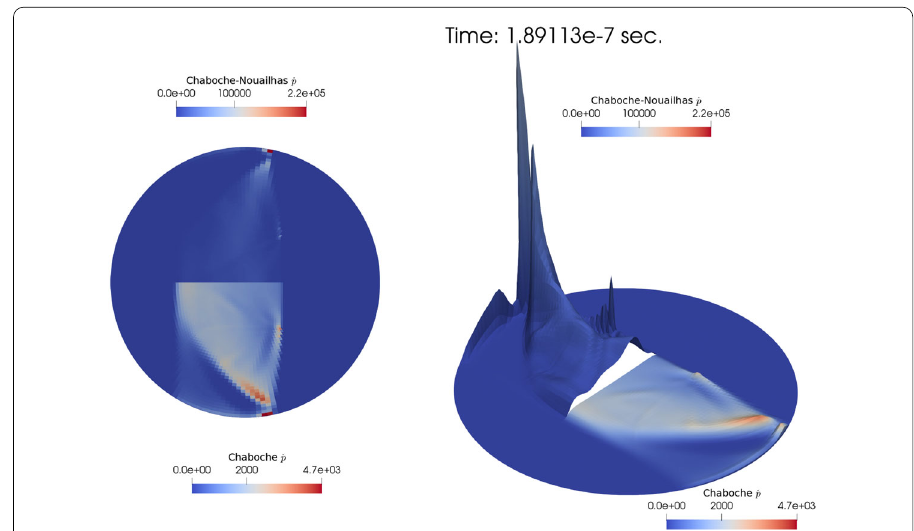
Fig. 24 Effective viscoplastic strain rate ˙ p in the inclusion at time 1 . 89 × 10 − 7 s, computed with Chaboche and Chaboche–Nouailhas’ viscoplastic constitutive models. Both unwarpped (left) and warpped (right) isovalues are presented, the latter being scaled with the same scale factor 10 − 8